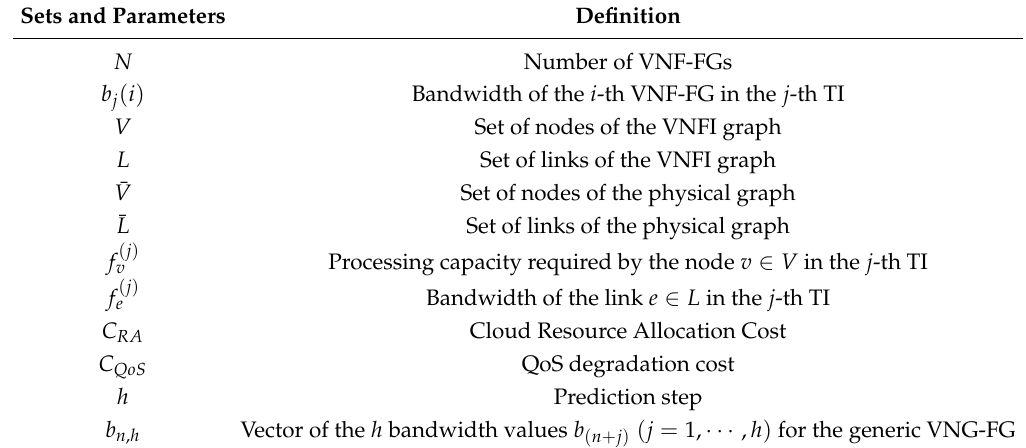
Table 2. Sets and Parameters.